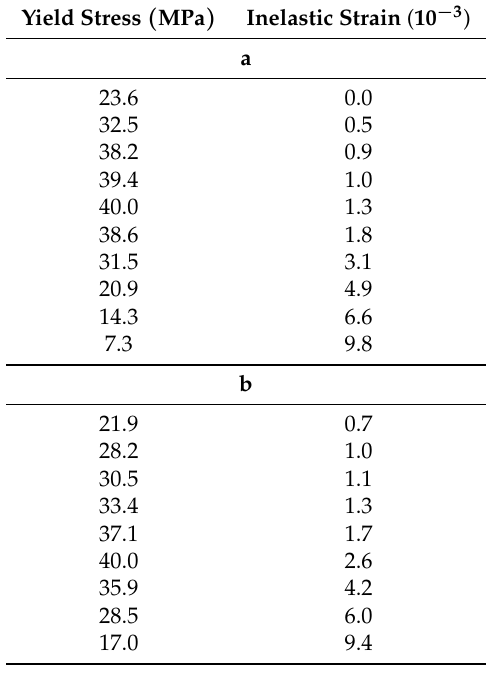
Table A1. Input values for compressive behavior at (a) room temperature, (b) 100 ◦ C, (c) 200 ◦ C, (d) 300 ◦